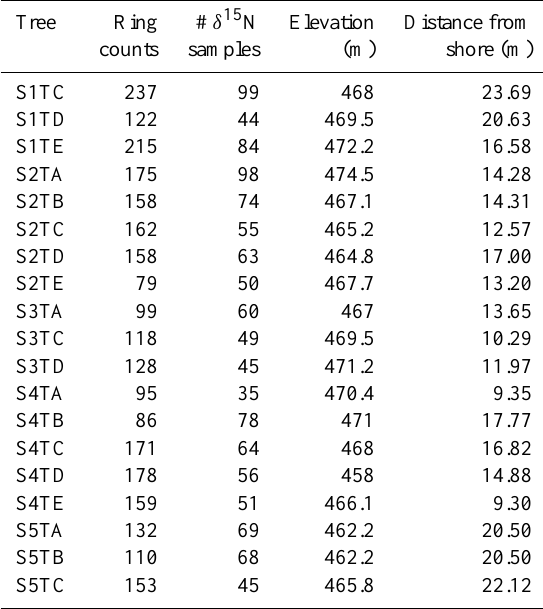
Table 1. List of the trees sampled, ring counts, the number of δ 15 N samples obtained from that tree, elevation in meters, and distance from shore in meters.